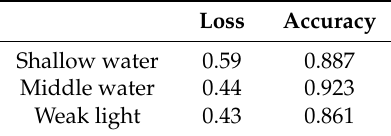
Table 2. Training optimal parameters.